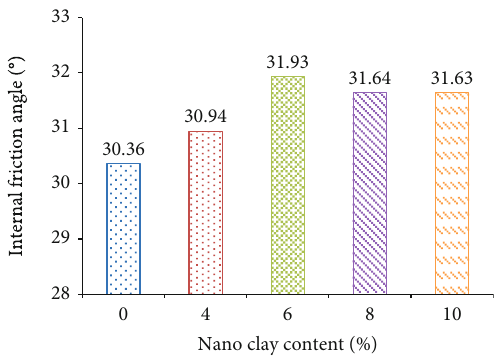
Figure 5: Relation of nanoclay content and internal friction angle of NCCS.